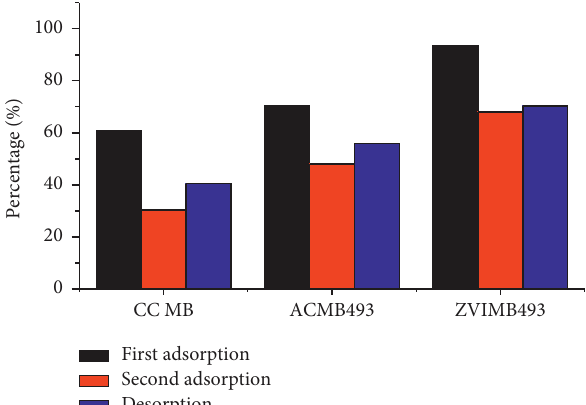
Figure 15: Effect of adsorption efficiency (%), desorption efficiency (%), and extraction process on percentage of β -carotene extracted.